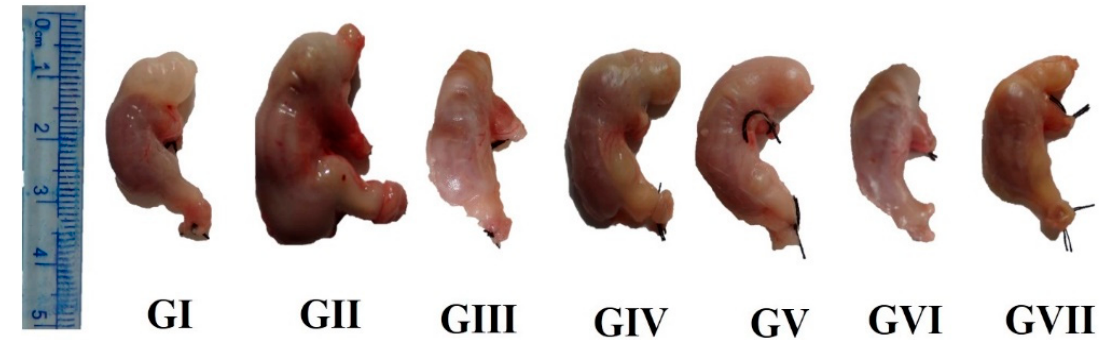
Figure 1. Stomach growth, appearance and volume of indomethacin-induced ulceration in rats: GI: negative control; GII: positive ulcer control; GIII: ulcer + SP; GIV: Ulcer + KF; GV: ulcer + KP; GVI: ulcer + SP, KF, KP; and GVII: ulcer+Lansoprazole (references group). Table 1. Effect of SP, KF, KP, and SFP extracts on volume and pH of gastric juice in indomethacin-induced gastric ulcer in rats (mean ± SE), n = 6. Physicochemical Parameters